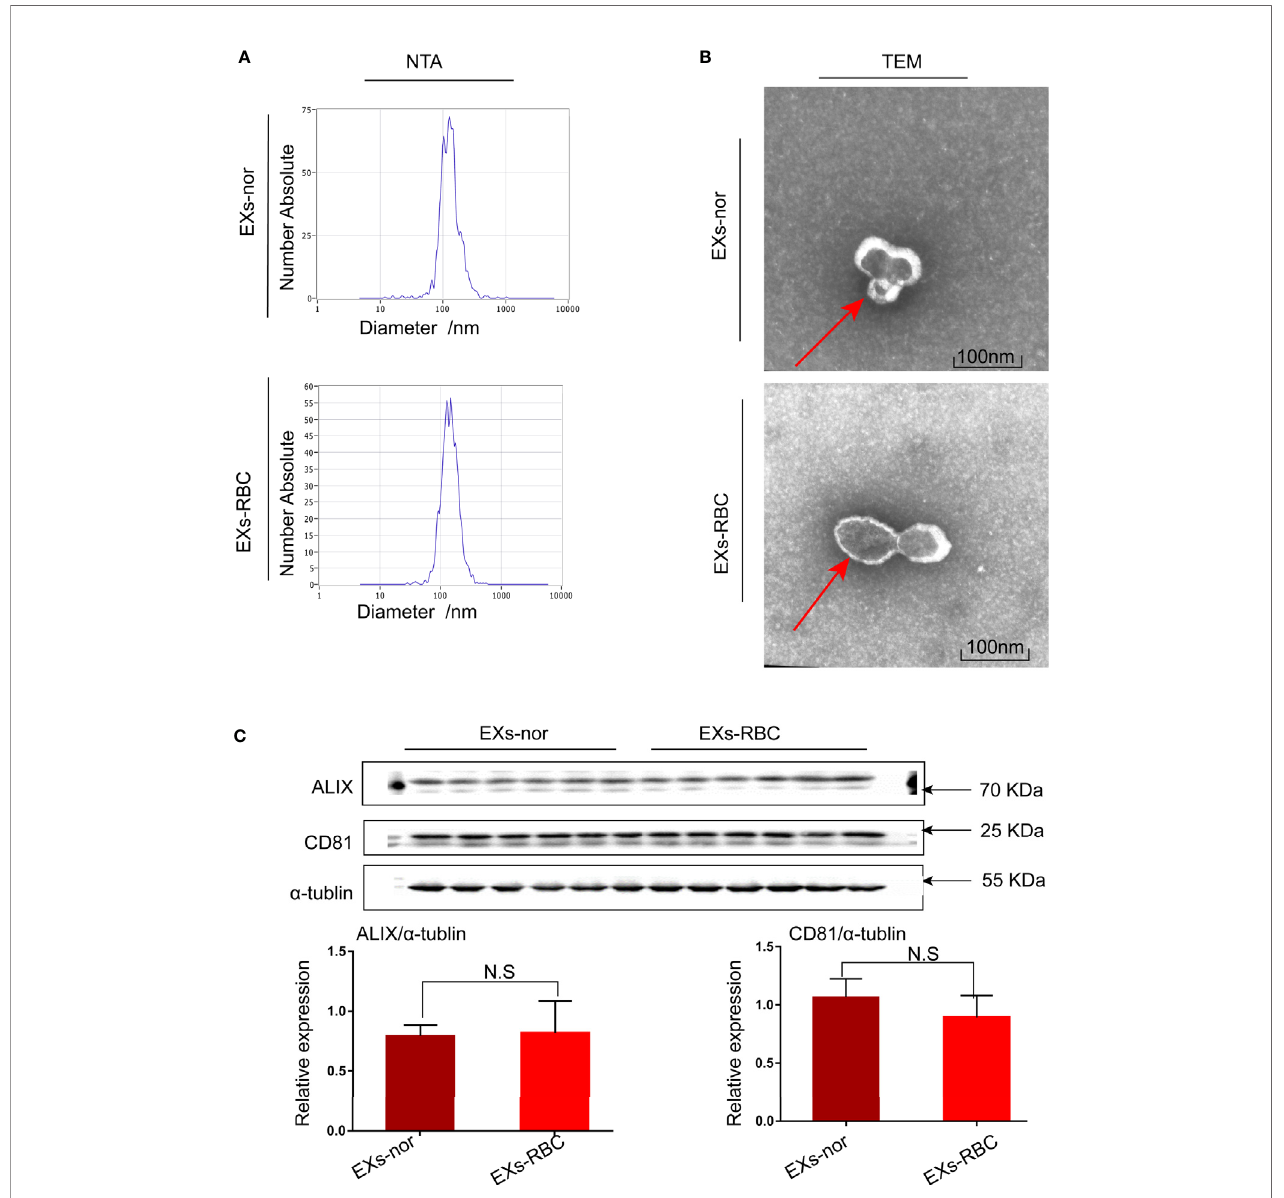
FIGURE 2 | Exosomes (EXs) were identi fi ed by nanoparticle tracking analysis (NTA), transmission electron microscopy (TEM), and western blotting analysis. Morphology and size of EXs-nor and EXs-RBC were analyzed using NTA and TEM. (A) Representative picture of NTA; 50 µL of EXs (four samples, two from EXs- nor, two from EXs-RBC) was diluted in 50 mL PBS, and NTA was performed. (B) Representative picture of TEM; 50 µL EXs was stained with 2% phosphotungstic acid for TEM. TEM revealed EXs that were membrane-bound; red arrow points to the membrane of EXs. Scale bars: 100 nm. (C) Western blotting for CD81 and ALIX, marker proteins of EXs. Six samples (3 for EXs-nor, 3 for EXs-RBC) with the same protein concentration were used in duplicate. Blots were quanti fi ed by Image J software and standardized to a -tubulin expression. Unpaired student t-tests were performed. There was no statistical difference in the expression of CD81 and ALIX between EXs-RBC and EXs-nor groups. NS, no statistical difference; EXs-nor, exosomes from normal volunteer plasma; EXs-RBC, exosomes from red cell